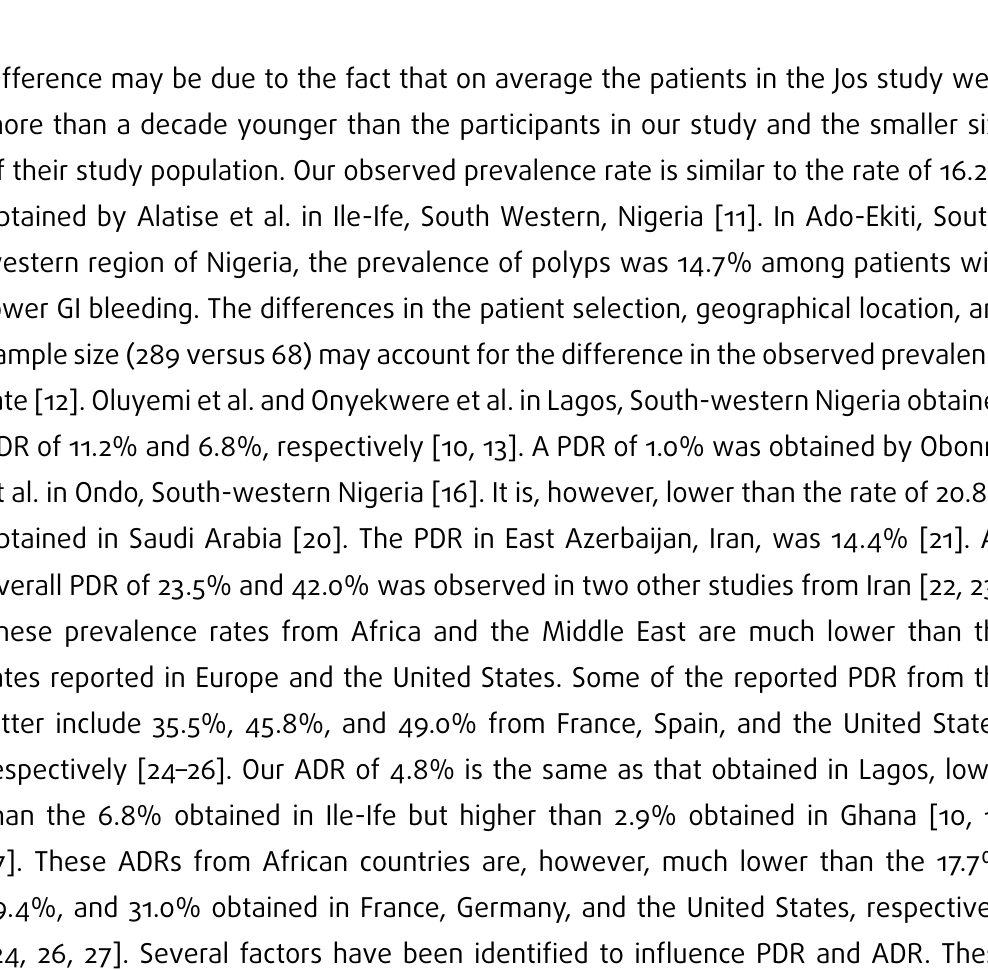
Figure 2: (a): Photomicrograph of tubulovillous adenoma polyp. (b): Photomicrograph of